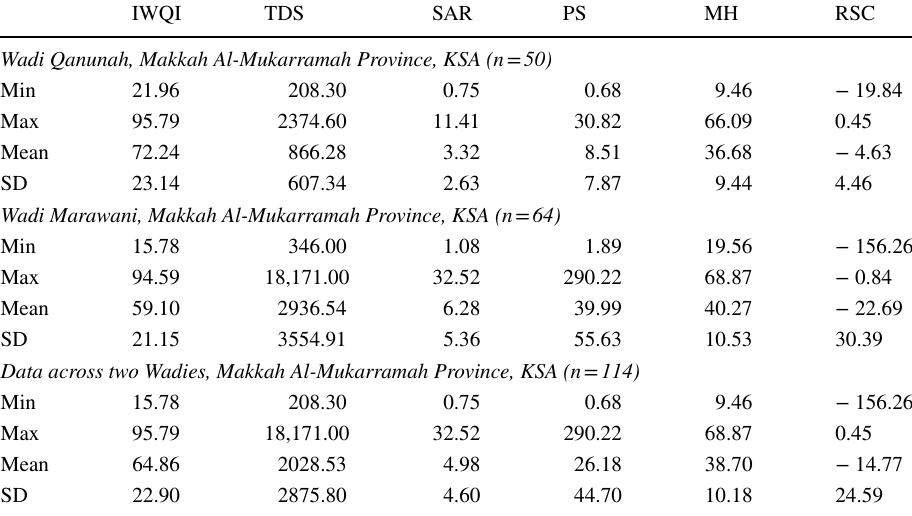
Min , Minimum, Max , Maximum, SD ,